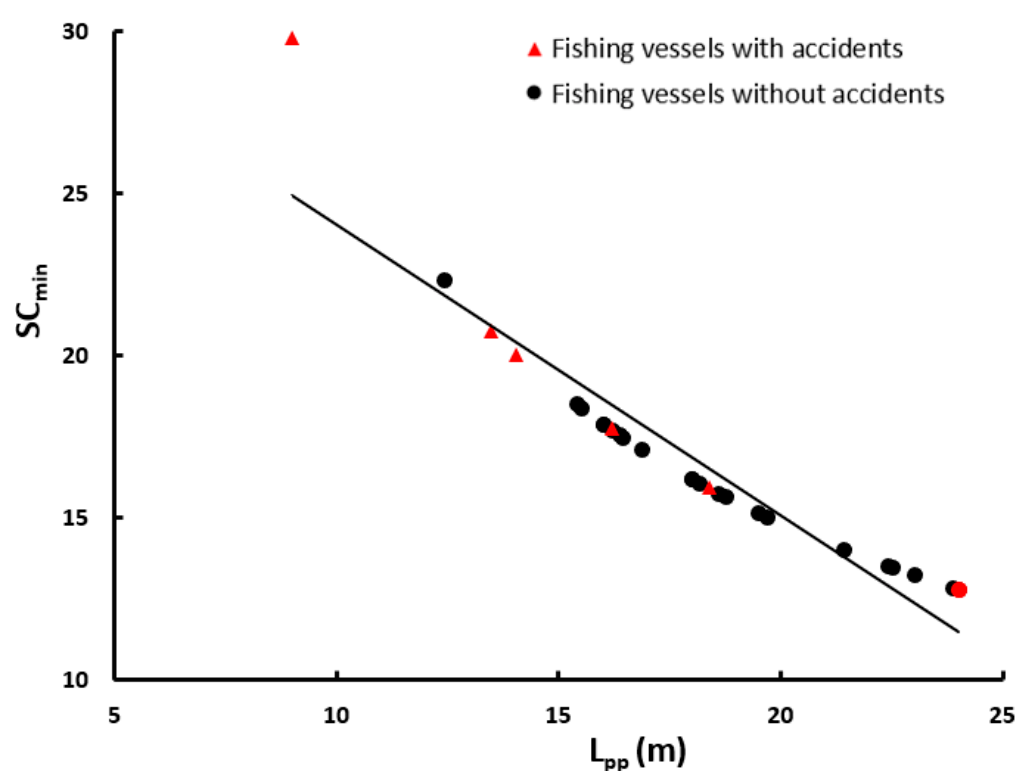
Figure 7. The minimum SC value as a function of the Meteorological and Oceanographic Criteria ( SC min ) of the analyzed vessels as a function of vessel length ( L pp ).